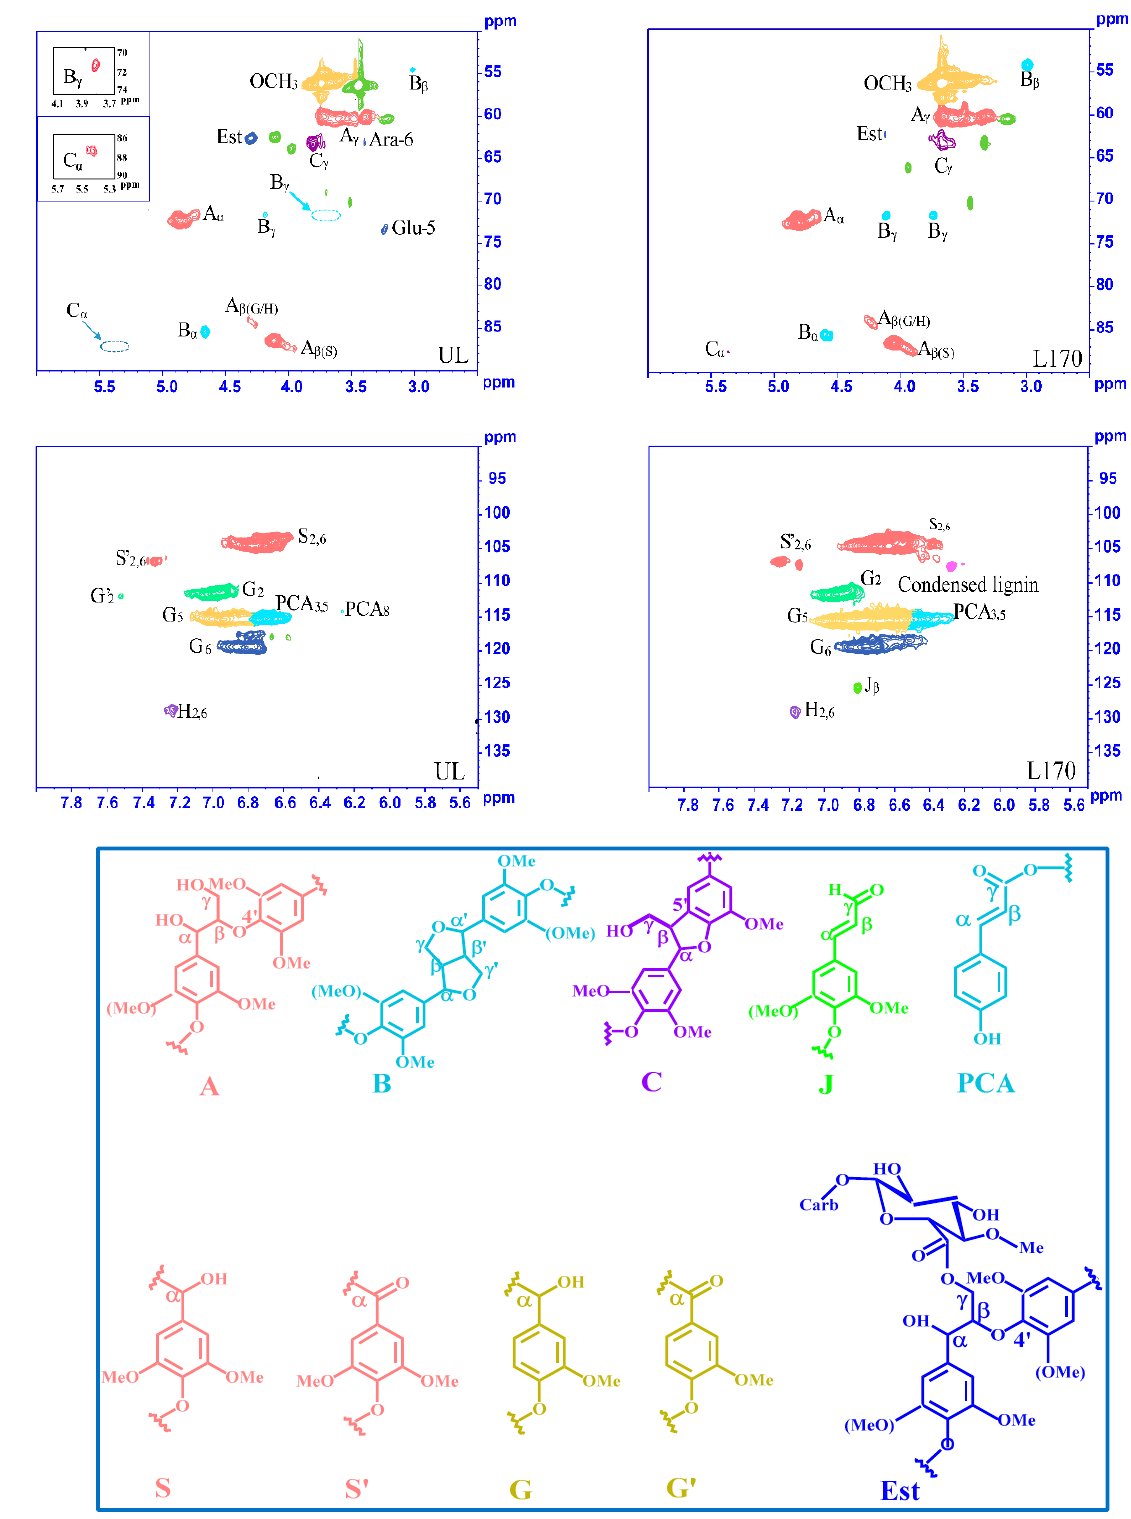
Figure 4. 2D-HSQC-NMR spectra of UL and L170 fractions and the main lignin substructure linkages present in lignin fractions: (A) β - O -4 aryl ether linkages; (B) resinol substructures; (C) phenylcoumaran substructures; (J) cinnamaldehyde end groups; (PCA) p -coumaric acid (ester); (S) syringyl units; (S ′ ) oxidized (C α =O) syringyl units; (G) guaiacyl units; (G ′ ) oxidized guaiacyl units with a C α ketone; (Est) γ -ester.